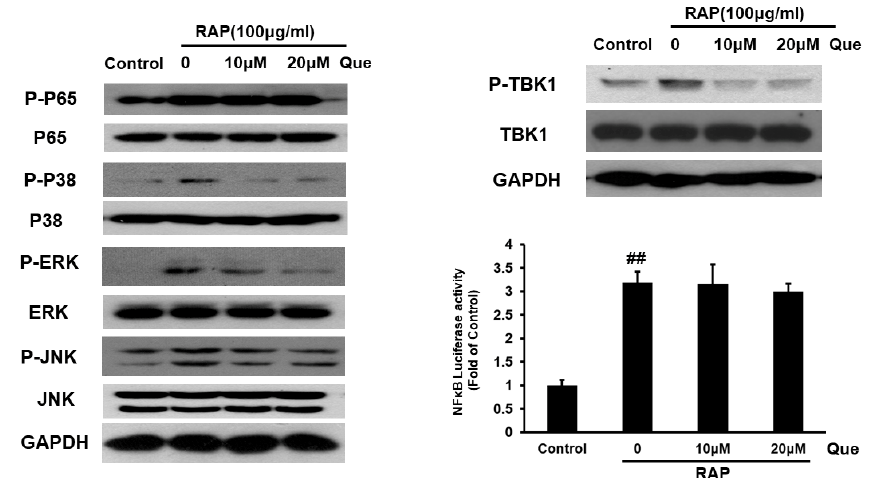
Figure 6. Effects of quercetin on RAP-induced p65, p38 MAPK, ERK1/2, JNK, TBK1 phosphorylation and NF κ B luciferase activity in RAW264.7 macrophages. RAW264.7 cells were treated with quercetin